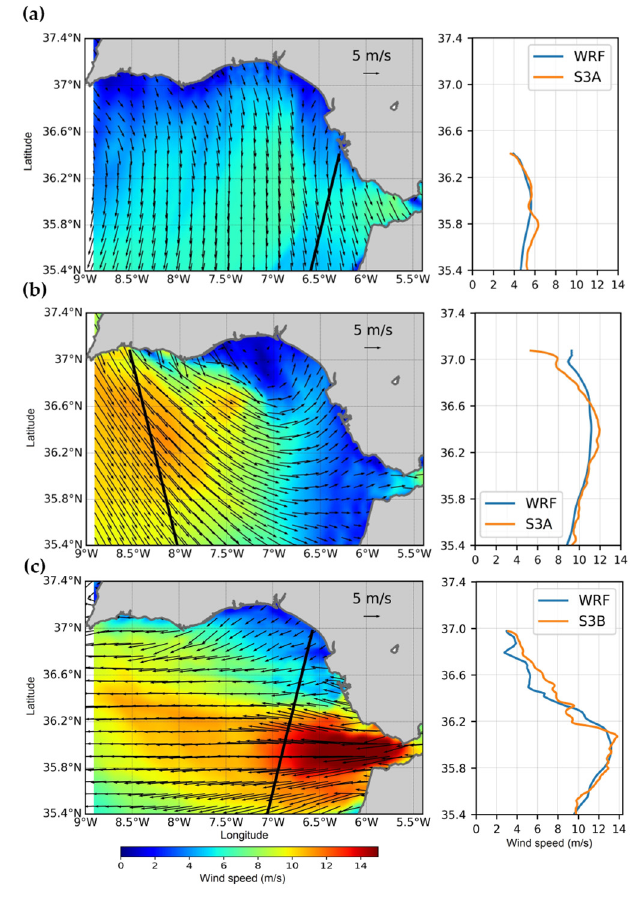
Figure 7. Wind field simulated by the WRF model overlaid with S3A/B track (left) and wind speed observed by S3A/B overlaid with interpolated WRF model data at the same positions for the closest available time. ( a ) 31 December 2020, WRF outputs for 11:00 UTC overlaid with S3A track at 10:35 UTC; ( b ) 25 June 2020, WRF outputs for 22:00 UTC overlaid with S3A track at 21:32 UTC; ( c ) 21 February 2020, WRF outputs for 11:00 UTC overlaid with S3B track at 10:37 UTC. During the satellite pass on 25 June 2020 at 21:32 UTC the wind field reproduced by